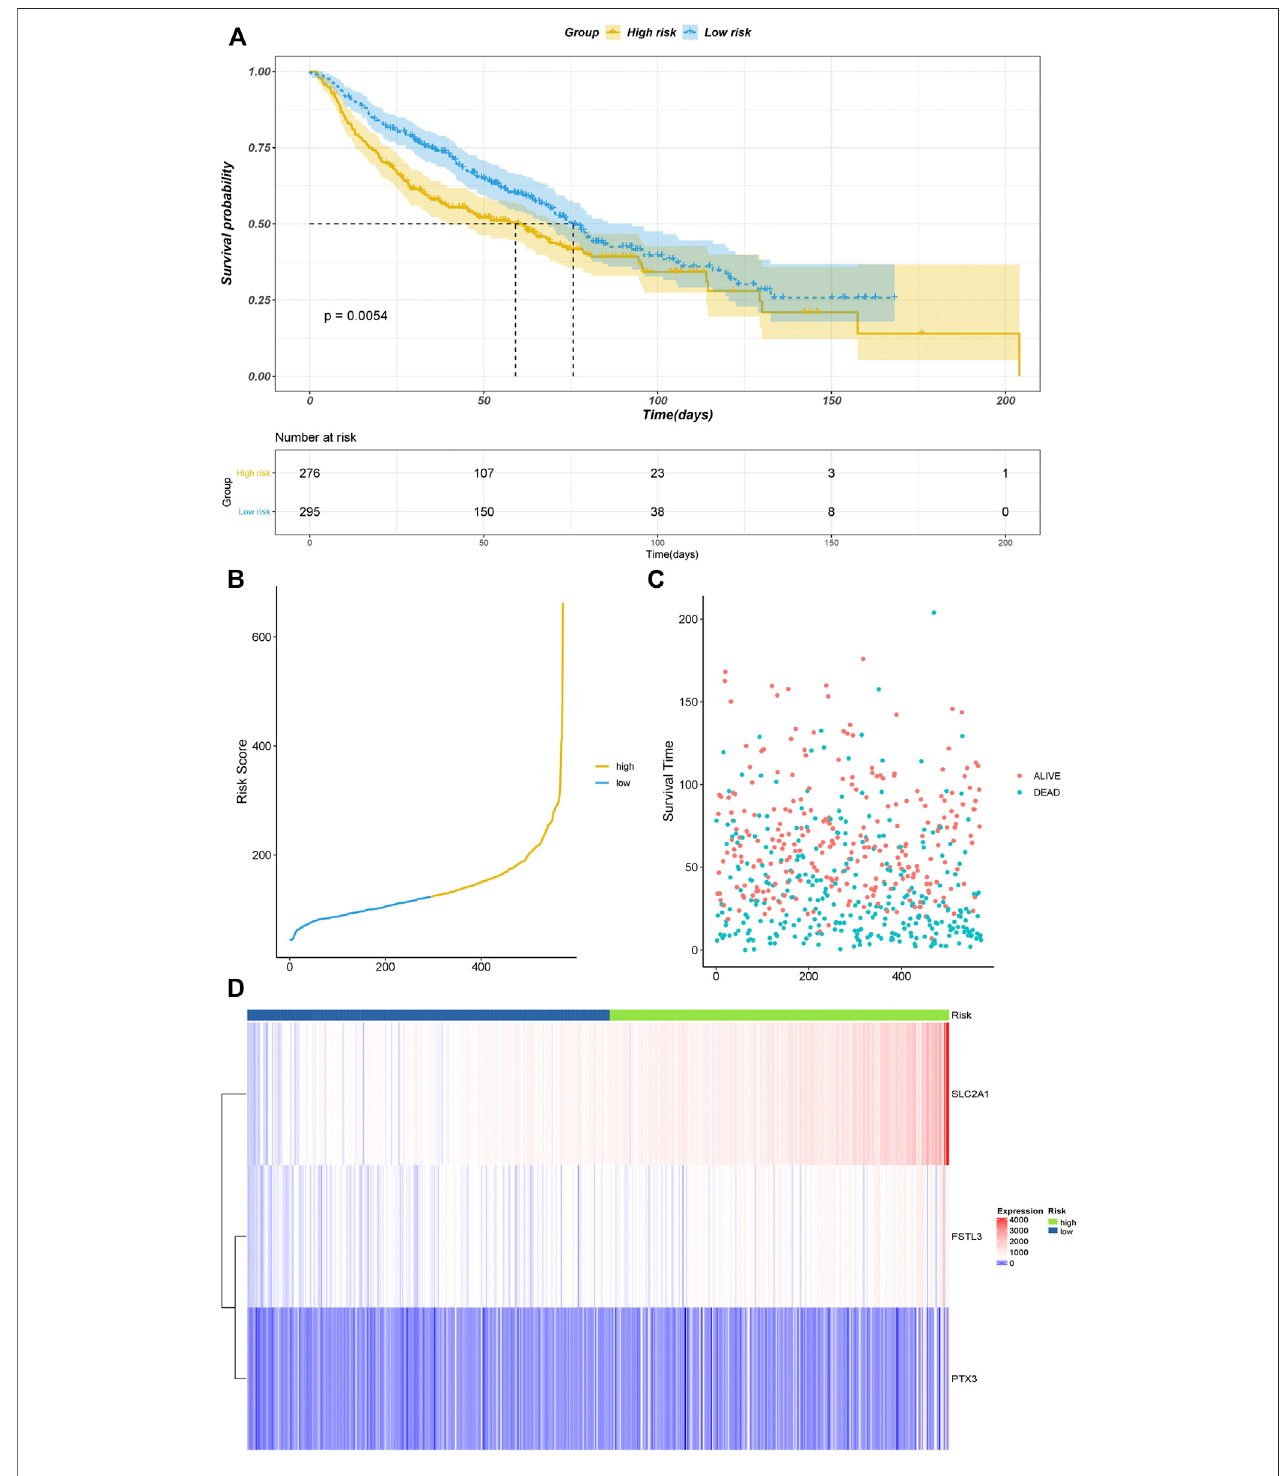
FIGURE 5 | Validation results of datasets GSE4573 and GSE68465. (A) Kaplan – Meier plot. (B) Risk score of all samples. (C) Scatter plot of the survival time of all samples. (D) Heatmap of the prognostic genes in high- and low-risk groups.